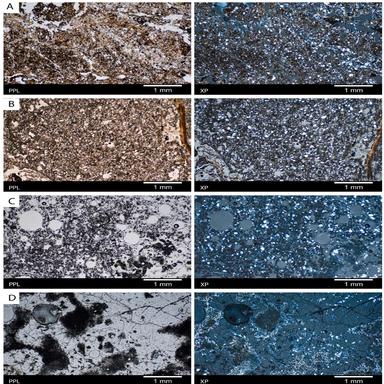
Thin-section photomicrographs of each petrographic entity in plain polarised light (PPL) and crossed polars (XP). A) A light brown (PPL) – grey (XP) nonvitrified matrix dominated by medium silt-very fine quartz grains (RW); B) A dark brown (PPL) – dark grey (XP) well sintered matrix dominated by medium silt-very fine quartz grains (ViS); C) Grey (PPL) – black (XP) continuous vitrified matrix dominated by quartz grains with newly formed, black micro-acicular mineral phases floating between the quartz grains